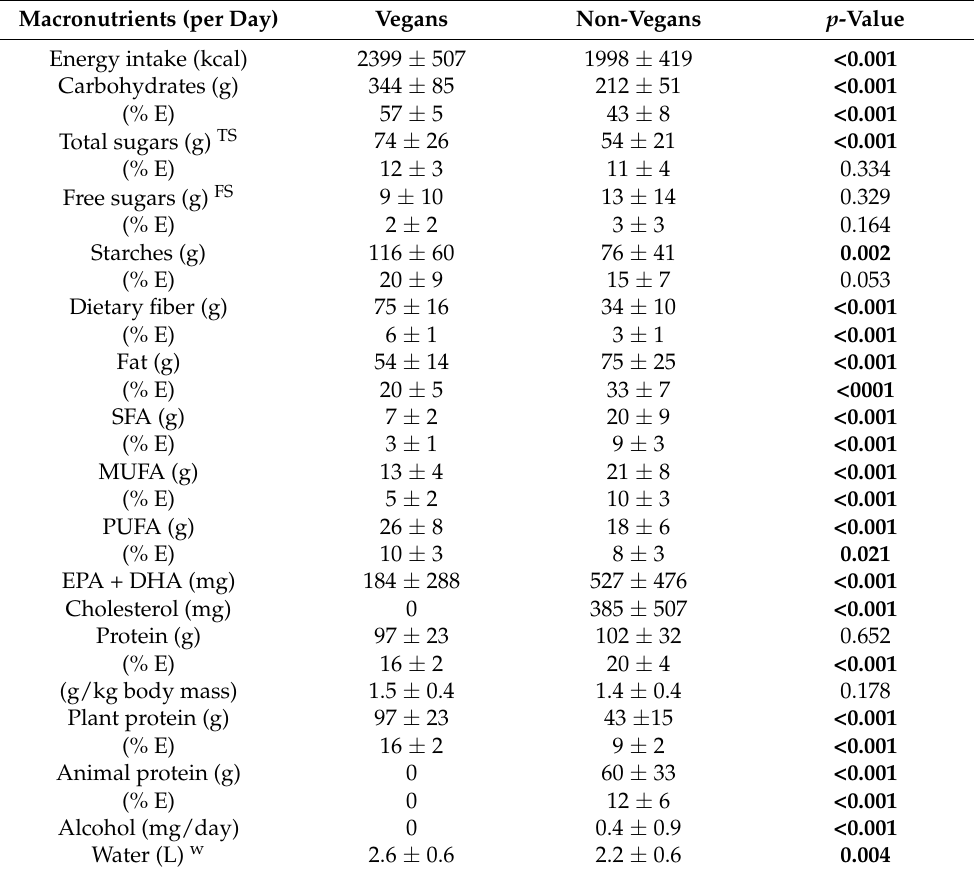
Table 2. Intake of energy and